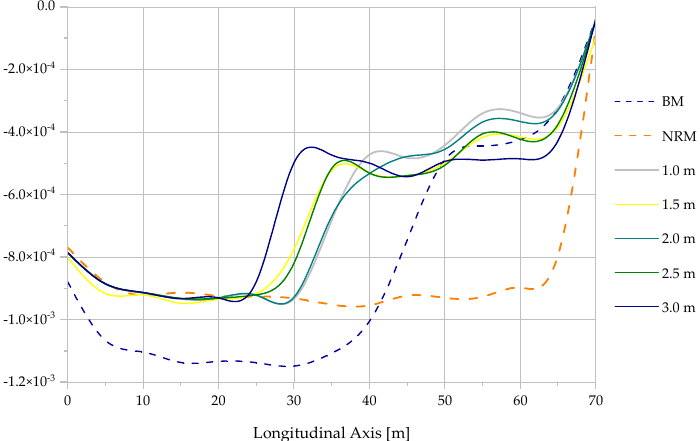
Figure 15. Vertical displacements when implementing the DHA90° with 50 and 40 BB sleepers per row in sets 1 and 2, respectively.